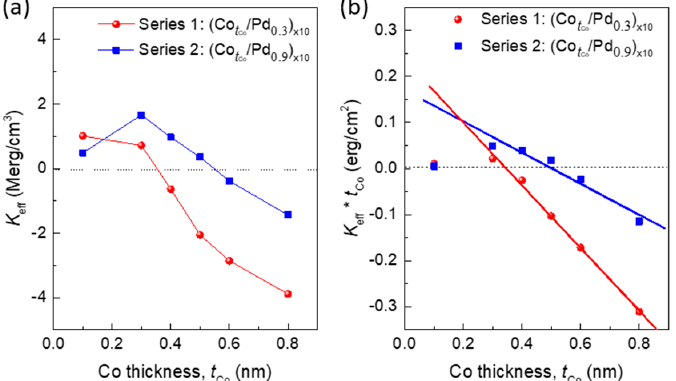
Figure 4. Plot of ( a ) effective anisotropy, K eff , of series 1 and series 2 as a function of t Co ; ( b ) K eff × t Co as a function of t Co , along with the straight line fit; red colour represents series 1 and blue colour represents series 2.